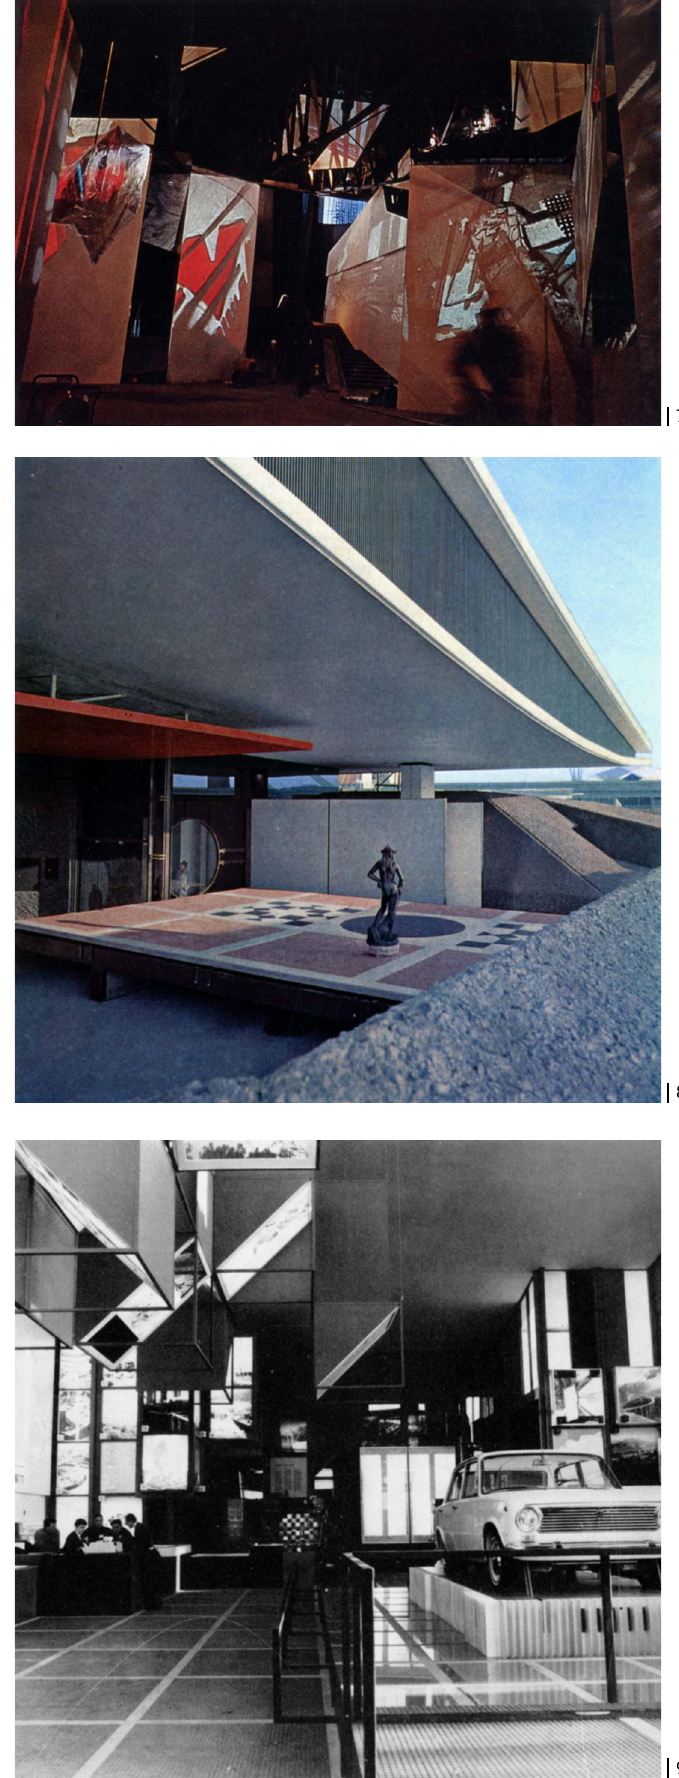
The Poetry section designed by Carlo Scarpa, 1967. From L’architettura. Cronache e storia 13, no. 141 (Jul. 1967). Fig. 9 The Industrialisation sector de- signed by Bruno Munari, 1967. From L’architettura. Cronache e storia 13, no. 141 (Jul.